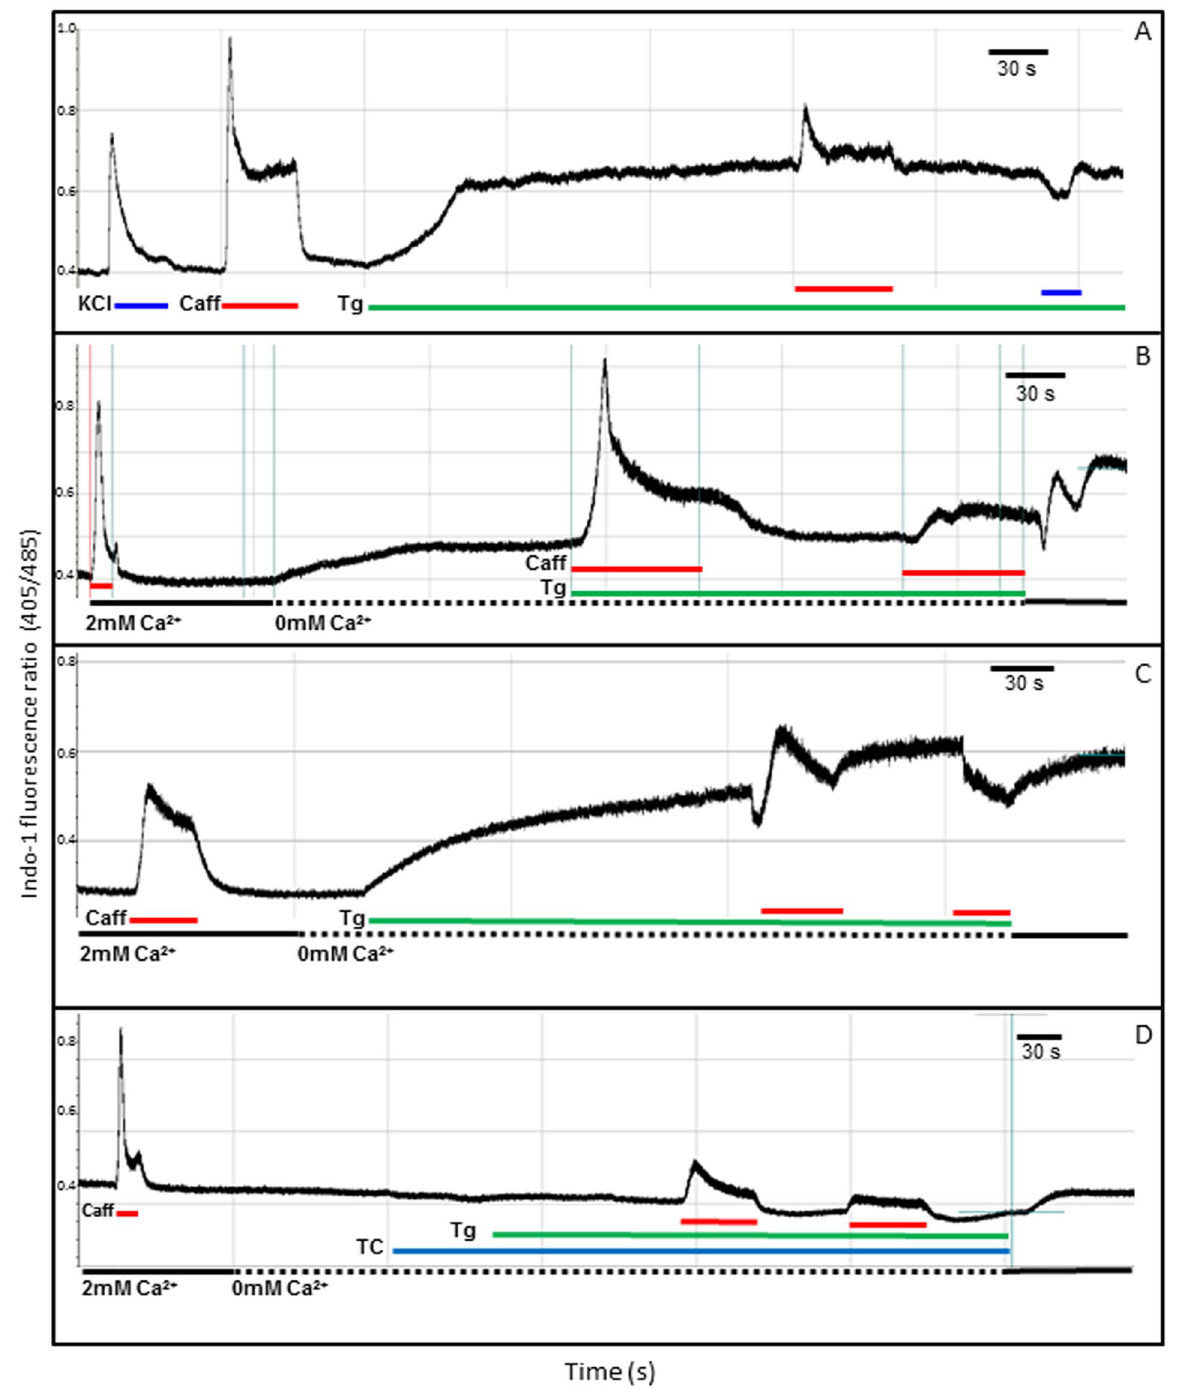
Figure 3. Calcium responses of skin-derived myotubes, treated with specific agonists and antagonists. A) Typical transients recorded following depolarisation with 60 mM KCl (blue line) and after exposure to 20 mM caffeine (red lines). The responses are almost abolished when the sarcoplasmic reticulum ATP-ase (SERCA-1) is blocked with thapsigargin (green line). Note that thapsigargin treatment induces an increase in Indo-1 fluorescence, that reveals leakage of SR calcium into the cytoplasm when SERCA-1 activity is blocked. B) Effect of thapsigargin on the response of skin-derived myotubes to caffeine, using calcium-free solution (dashed line). The increase in Ca 2 + signal after the blockage of SERCA-1 supports the hypothesis of a leaky RYR-1 channel. C) Thapsigargin treatment was assayed on myotubes derived from primary, differentiated myoblasts, confirming that a similar leakage from the SR also occurs in these cells. D) When tetracaine is added to the perfusion system prior to the initiation of thapsigargin, the leakage is completely blocked, suggesting that RYR-1 is responsible for the leakage of SR calcium.